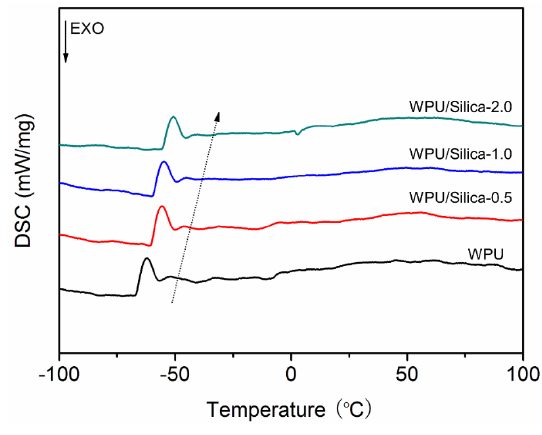
Figure 8. DSC curves of WPU and WPU/Silica coatings.